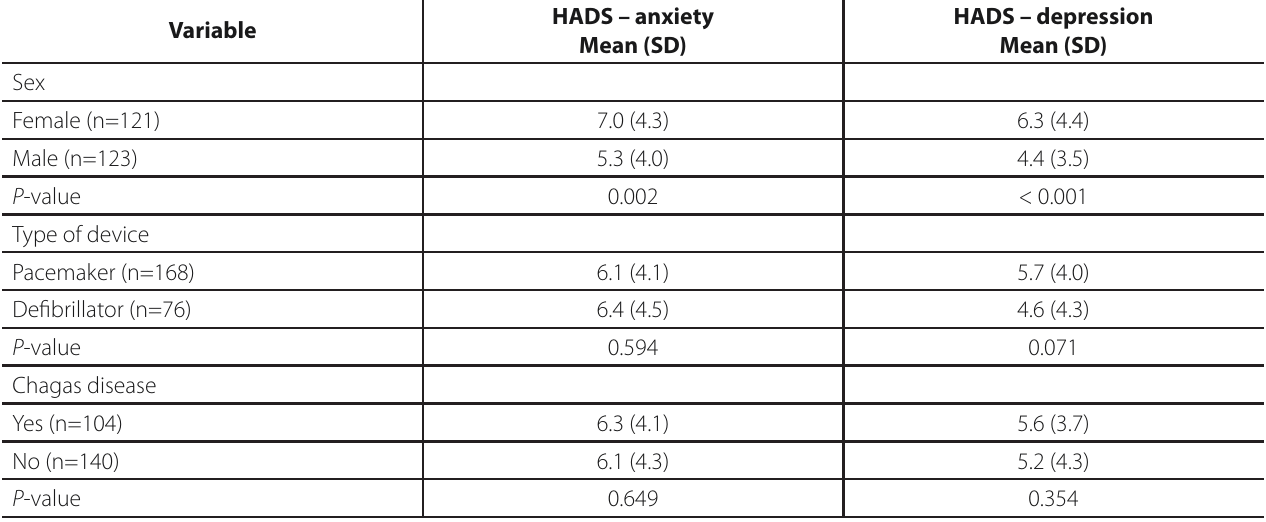
Table 3 . Comparison of the means of the subscales of the Hospital Anxiety and Depression Scale (HADS) instrument according to the sex of the participants, type of device, diagnosis of Chagas disease, and probability values ( P ) associated with Student’s t -test. Ribeirão Preto,